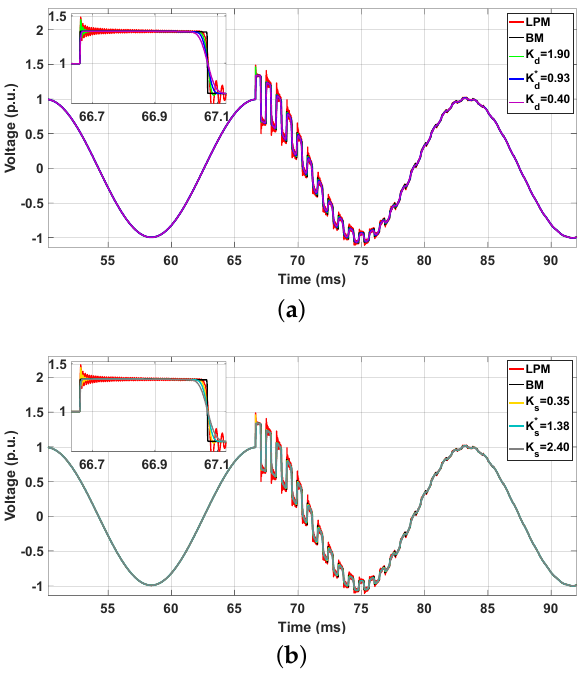
Figure 10. V m ( t ) for the 50-km single-phase TL in scenario 2: ( a ) LPM, BM and T 1 and ( b ) LPM, BM and T 2 .